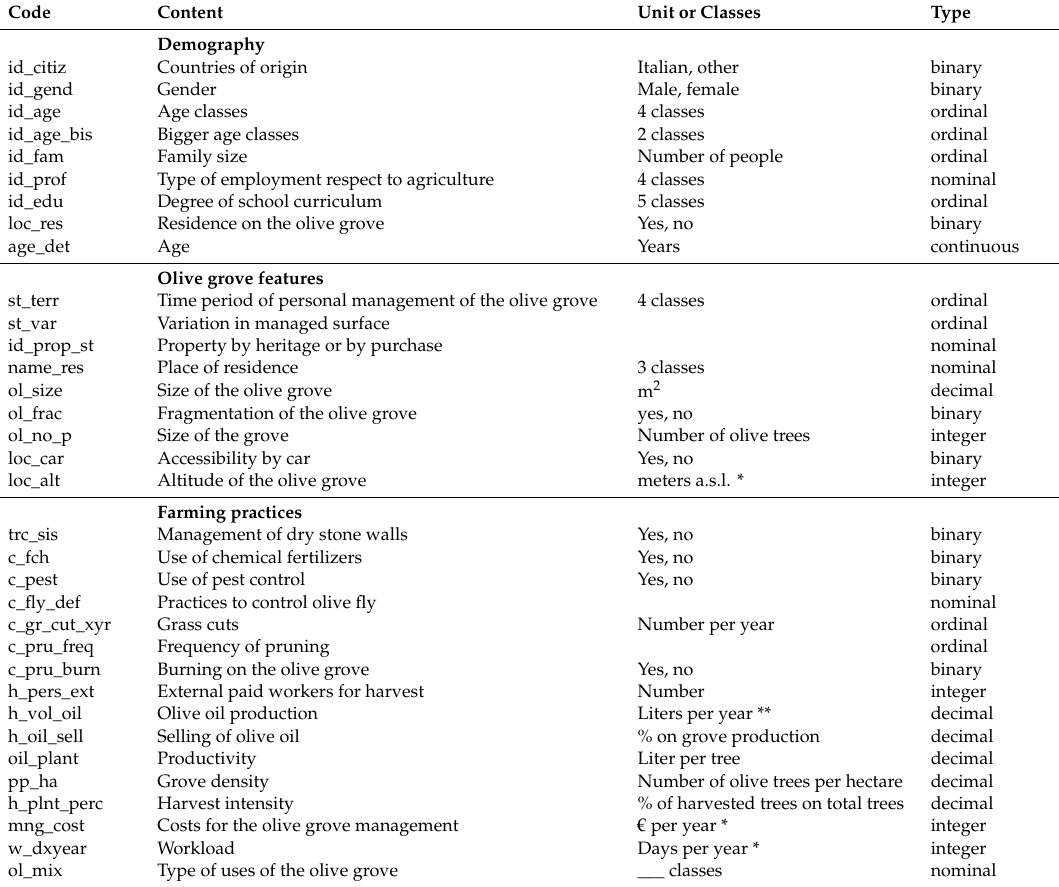
Table 2. Variables and average values on hobby